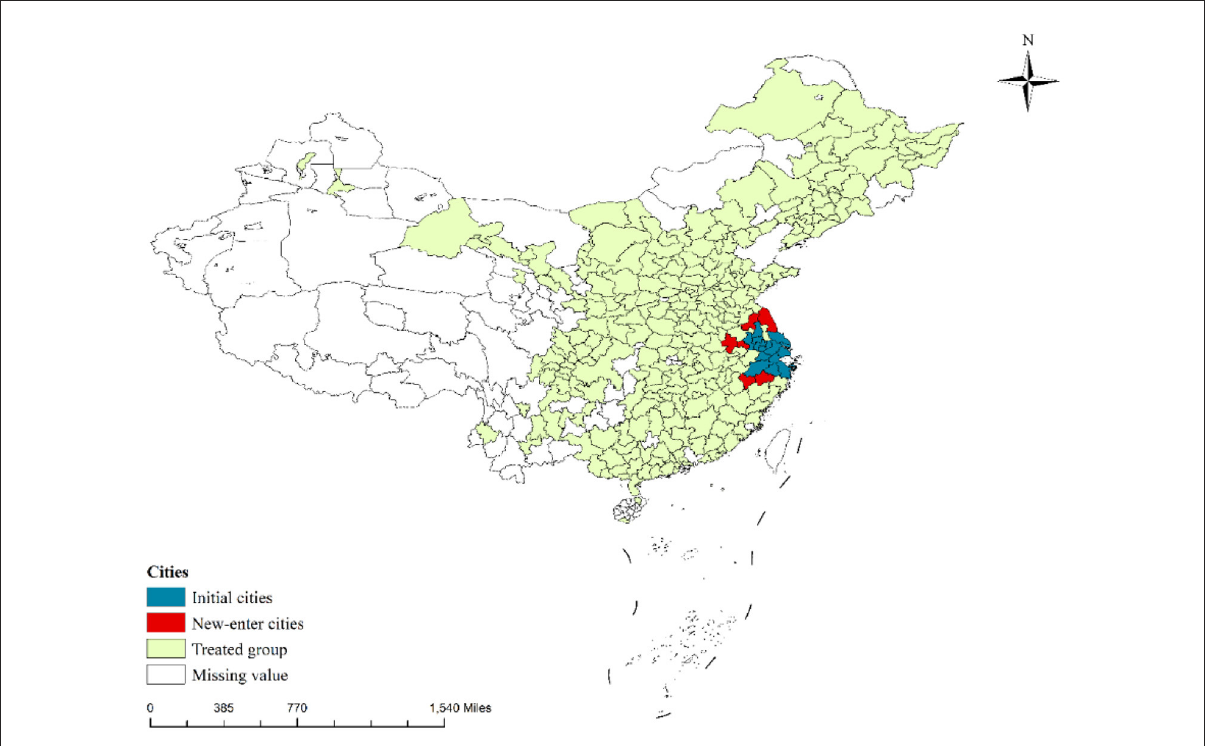
FIGURE1 Spatial distribution of Yangtze River Delta